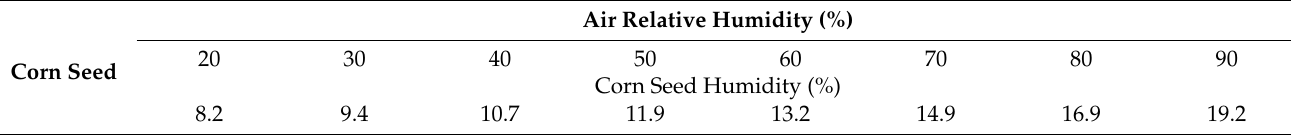
Table 3. Seed balance moisture depending on air relative